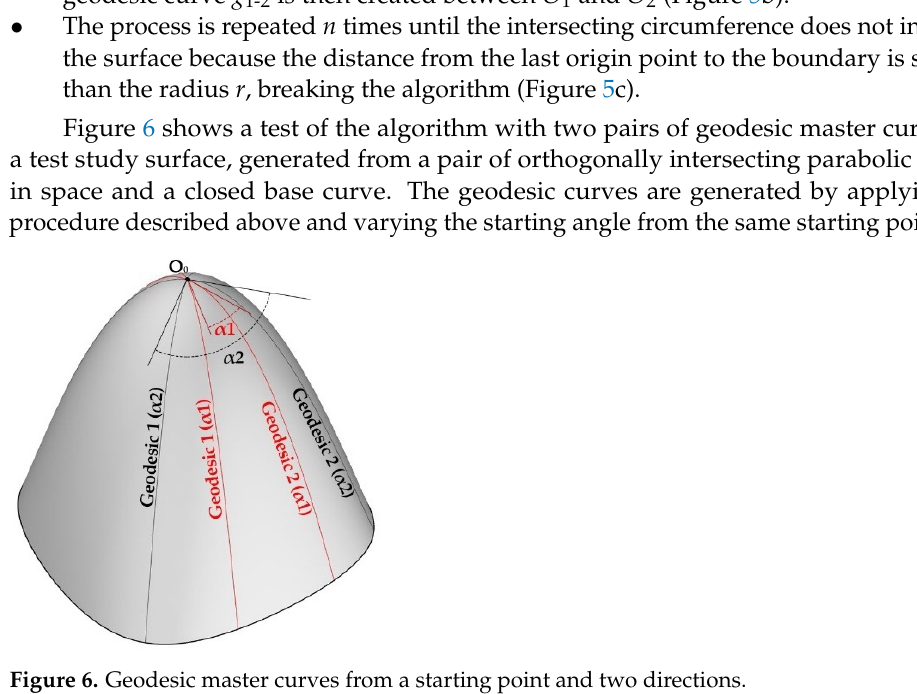
Figure 6. Geodesic master curves from a starting point and two directions.